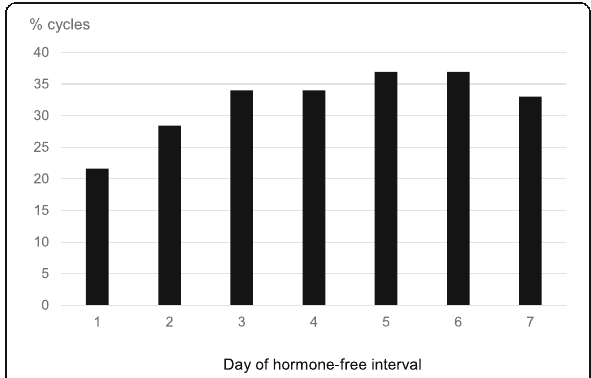
Fig. 2 Frequency of migraine days in the seven days of the hormone-free interval of combined hormonal contraceptive